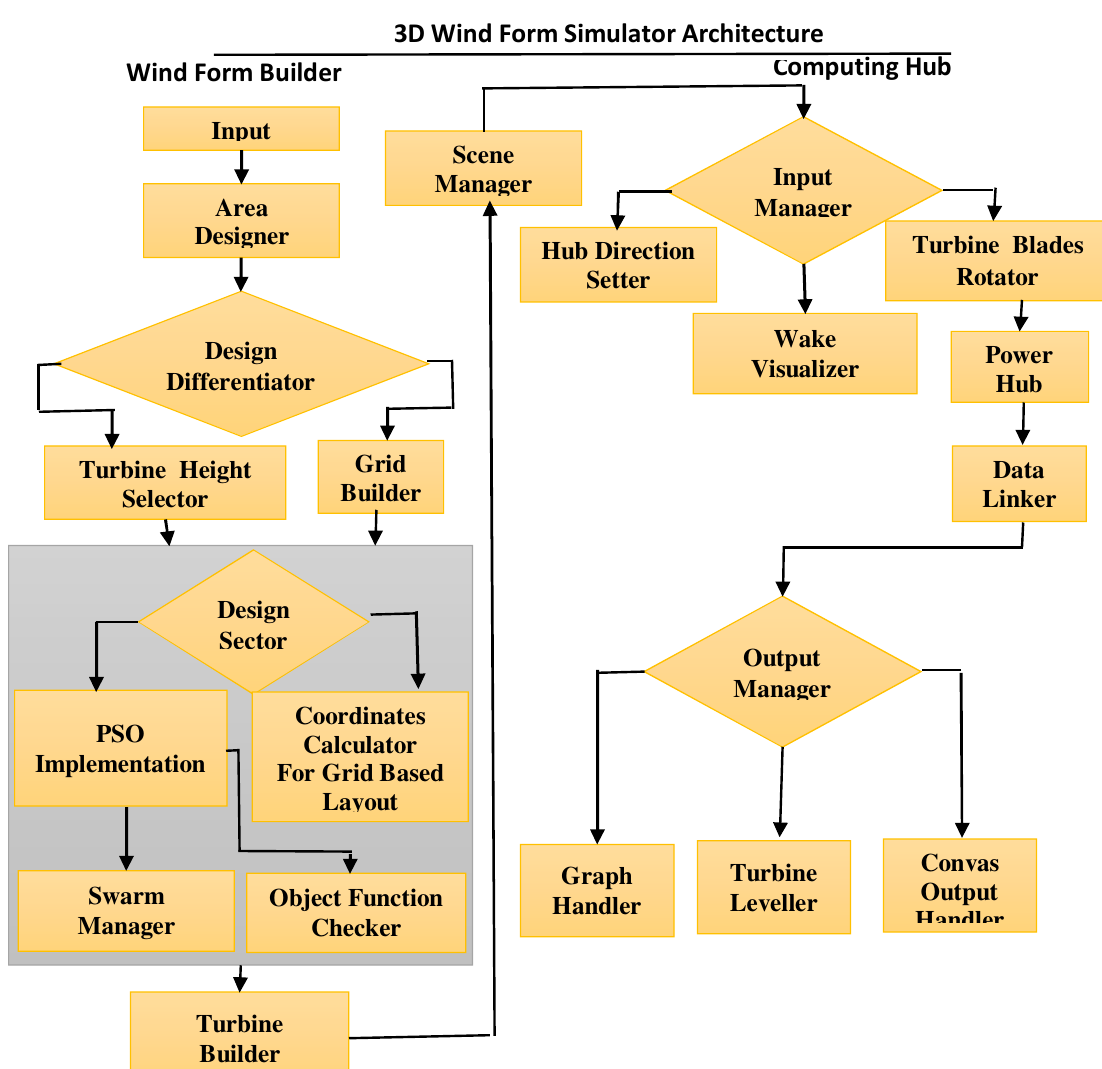
Fig. 2. Flow chart of proposed 3D wind farm